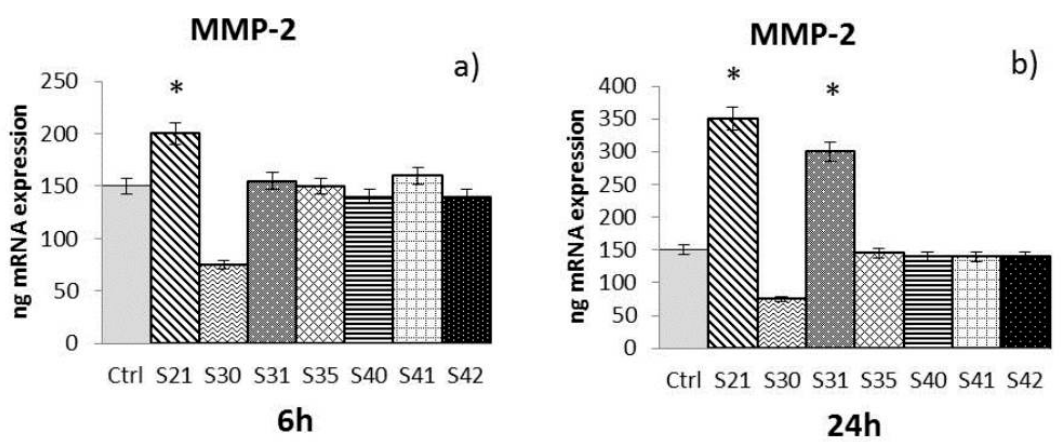
Figure 3. mRNA expression of Metalloproteinase-2 (MMP-2) from HaCat cells treated with S21, S30, S31, S35, S40, S41 and S42 non-woven tissue bio-composites (10 μ g/mL) for 6 h ( a ) and 24 h ( b) . Data are mean ± SD of values calculated on two different experiments. *P < 0.05 compared to Ctrl.